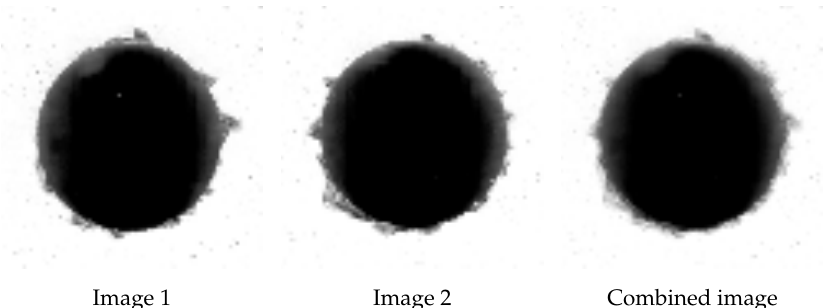
Figure 5. Creation of additional data entry for images belonging to class 2.